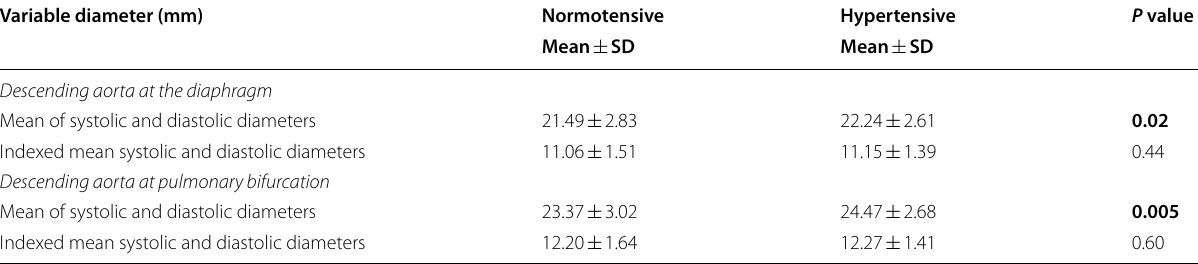
Bold mean significant values that is less than or equal 0.05